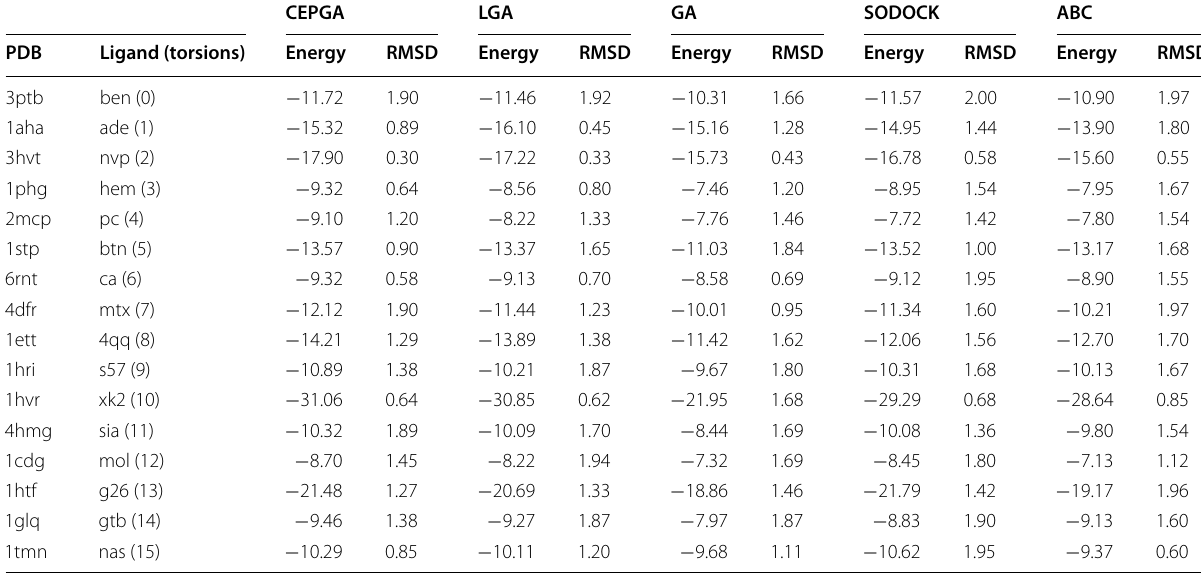
Table 2 Lowest energy and smallest RMSD results of five compared algorithms CEPGA LGA GA SODOCK